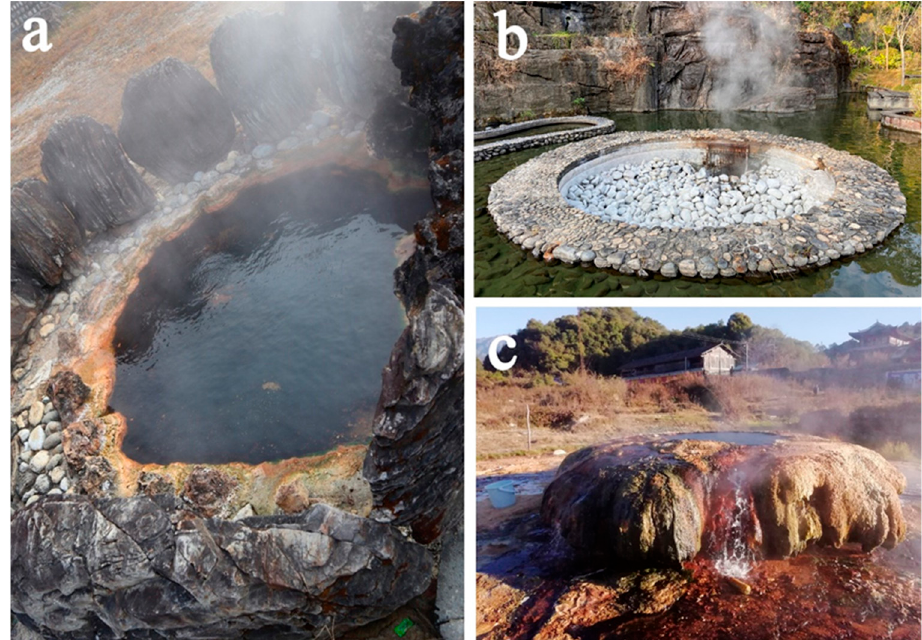
Figure 2. The photos of sampling sites: ( a ) the Shiqiang vent, ( b ) the Dafeiquan vent, ( c ) and the Shiqiang vent surrounded by larger travertine deposit.